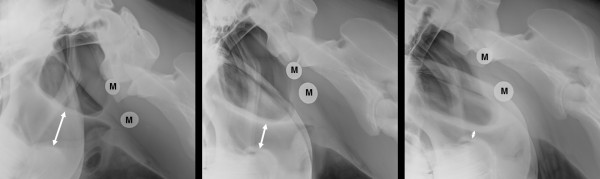
Lateral radiographs of the head. Lateral radiographs of the head were obtained in three head and neck positions. Left: extended head and neck position. Middle: neutral head and neck position. Right: flexed head and neck position. The pharyngeal diameter was defined as the shortest distance between the epiglottis and the roof of the pharynx (double-headed arrow). The metallic markers (M) were used to calculate the amplification factor as described by Cehak et al. [16].